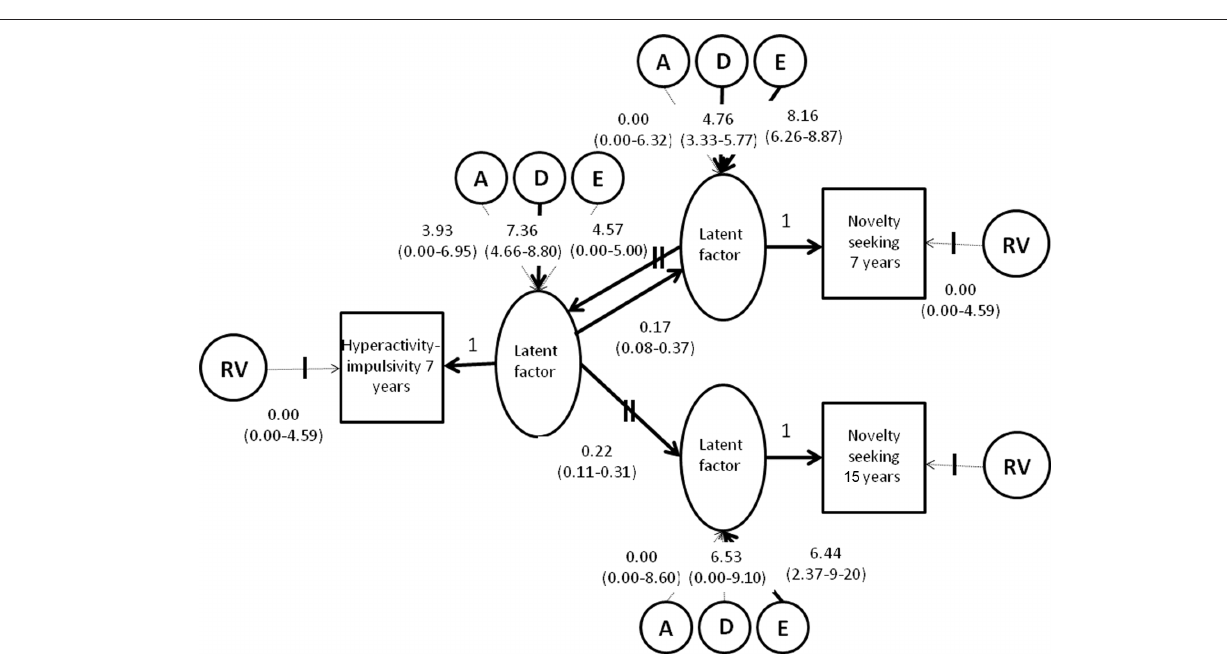
FiGure 2 | unstandardized solution of the best fitting direction of causation model ( + 95% confidence intervals; significant paths in bold). Note: Measured variables are represented by squares and described in the “Materials and Methods.” Latent (unmeasured) variables are represented by circles according to tradition (McArdle,